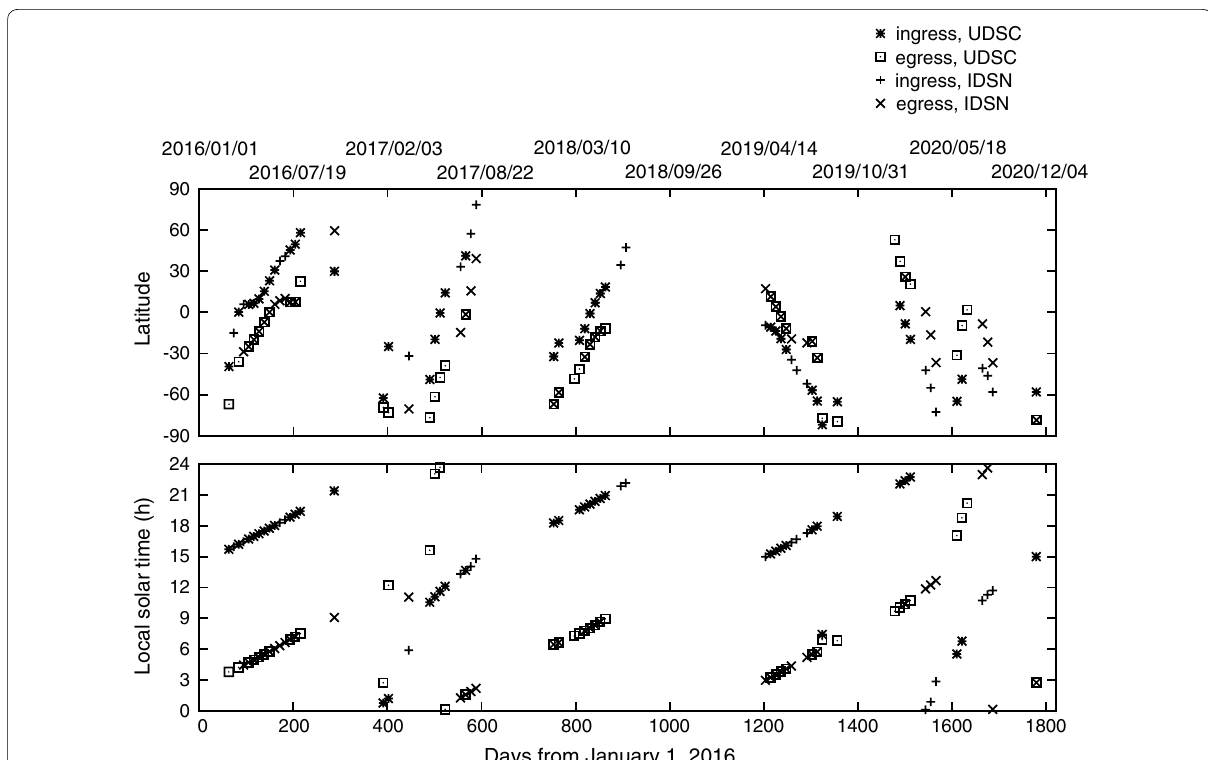
Fig. 2 (Upper) Latitudes and (lower) local solar times of the observation points from January 2016 to December 2020 for the two tracking stations, UDSC of JAXA and IDSN of